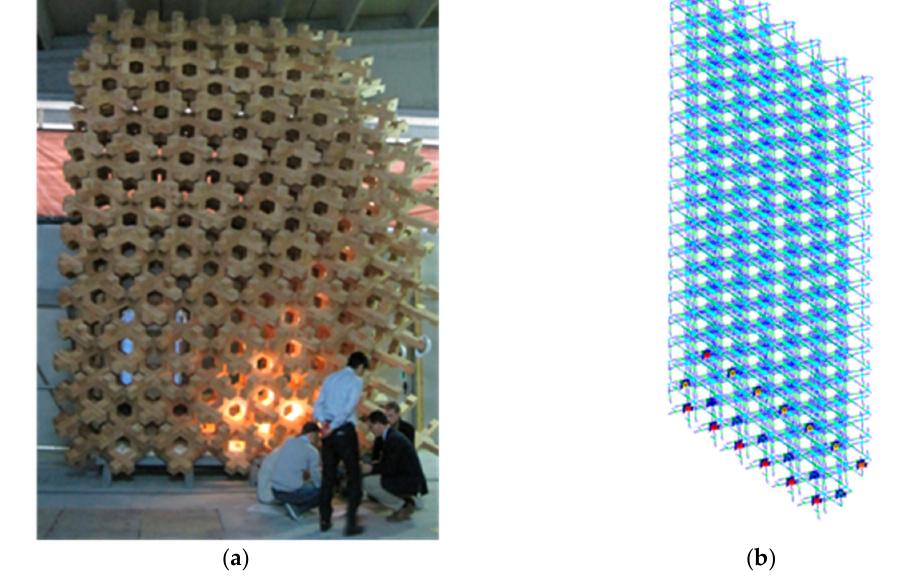
Figure 3. The prototype of wooden walls ( a ); the structural model ( b ) (source: Galloppini Legnami).